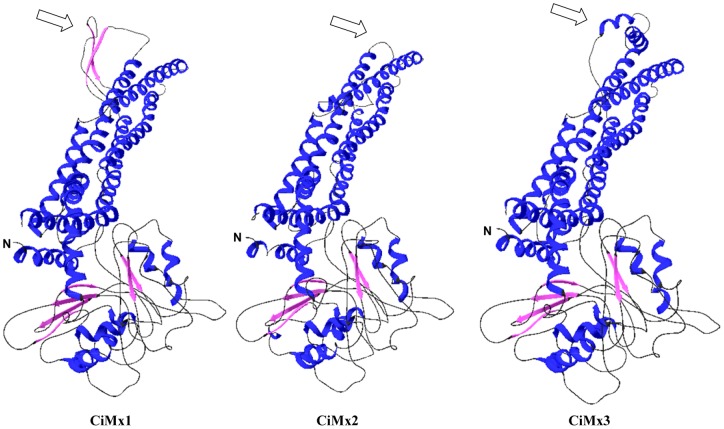
The spatial structures of three grass carp Mx isoforms predicted by SWISS-MODEL program.Blue, α-helices; pink, β-sheets; black, random coil. The hollow arrows mark the various structure among the three isoforms. In amino acid position 509–540, Glu517-Lys523 (overlapping with CID) and Leu534-Asp540 form two β-sheets in CiMx1; Ser509-Asn516 (overlapping with CID) forms α-helix in CiMx2; Ala512-Asp519 (overlapping with CID) and Thr525-Thr538 (overlapping with GED) form two α-helices in CiMx3.